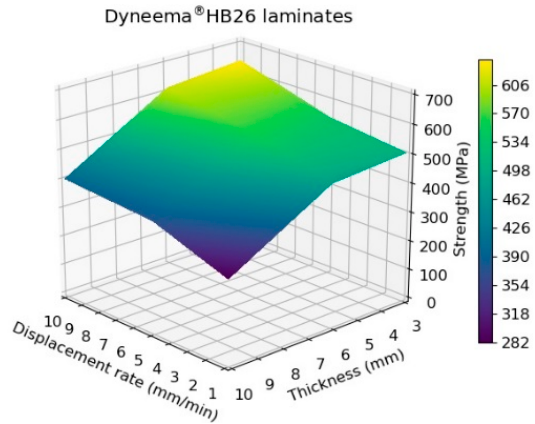
Figure 7 . Tensile strength of Dyneema ® HB26 laminates as function of thickness and displacement rate.